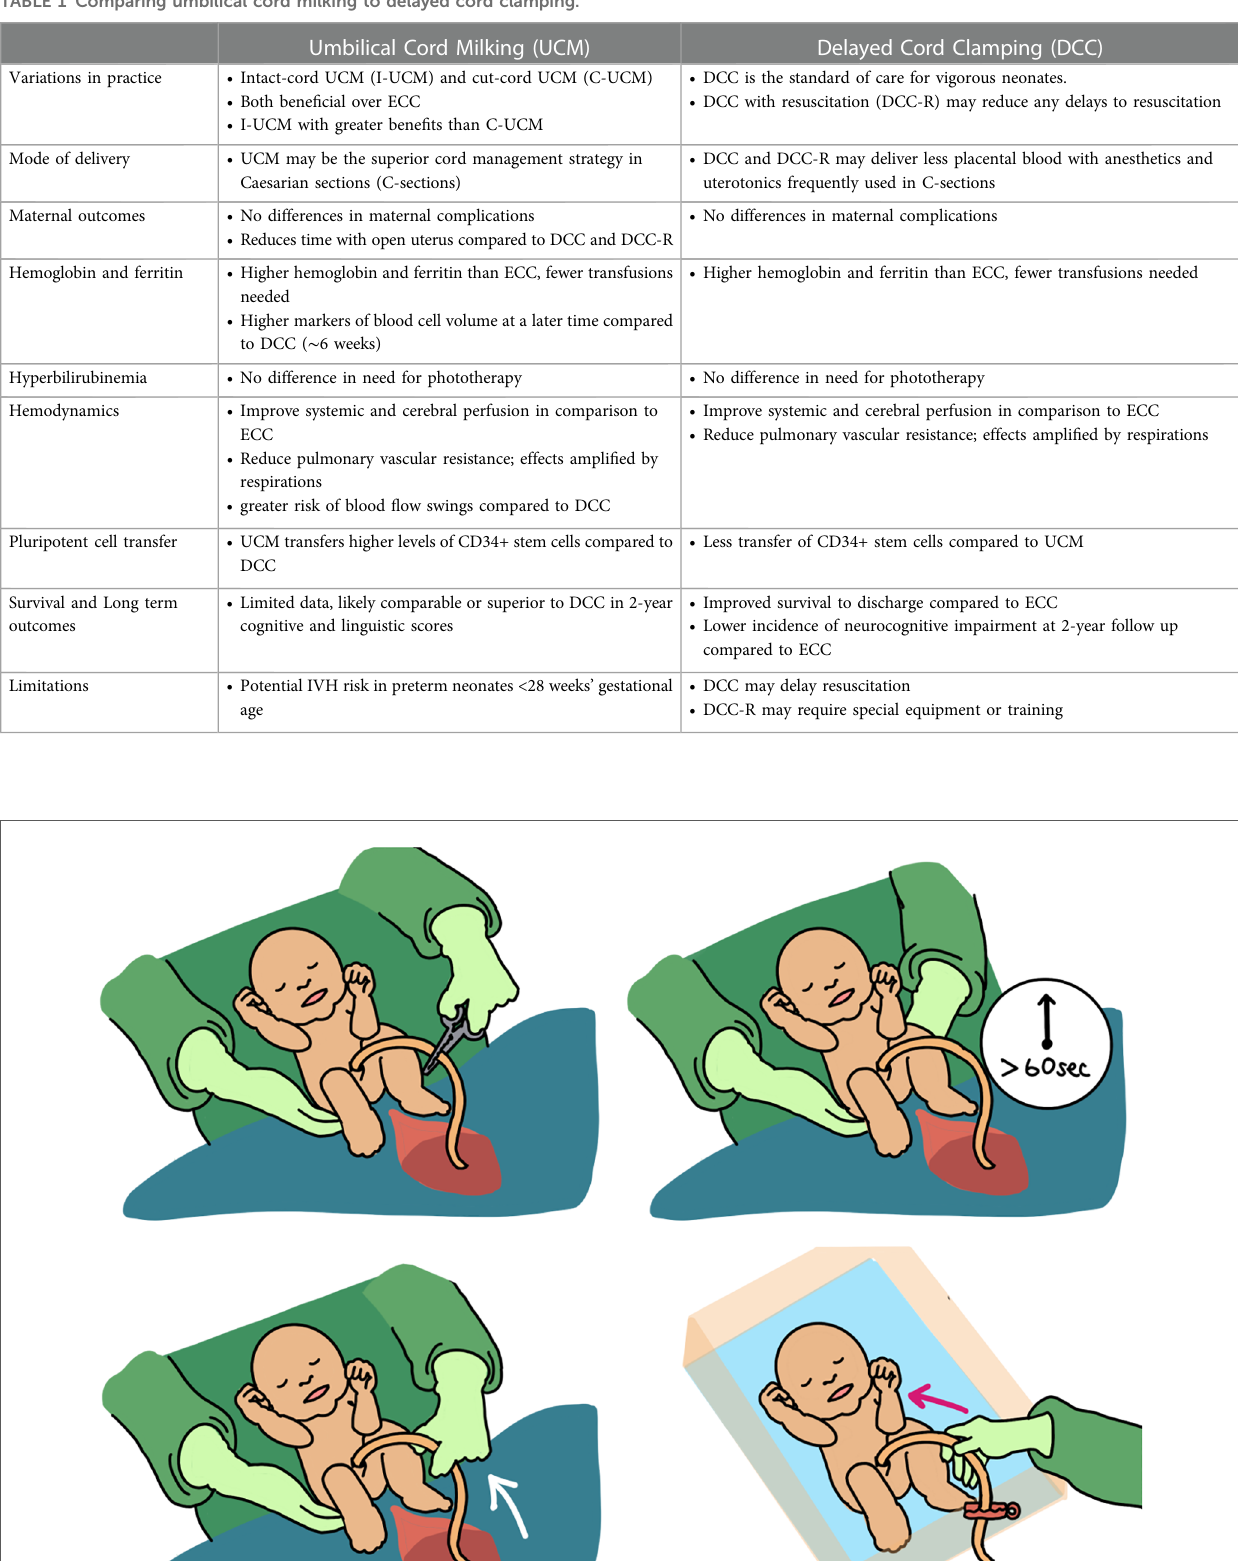
TABLE 1 Comparing umbilical cord milking to delayed cord clamping.